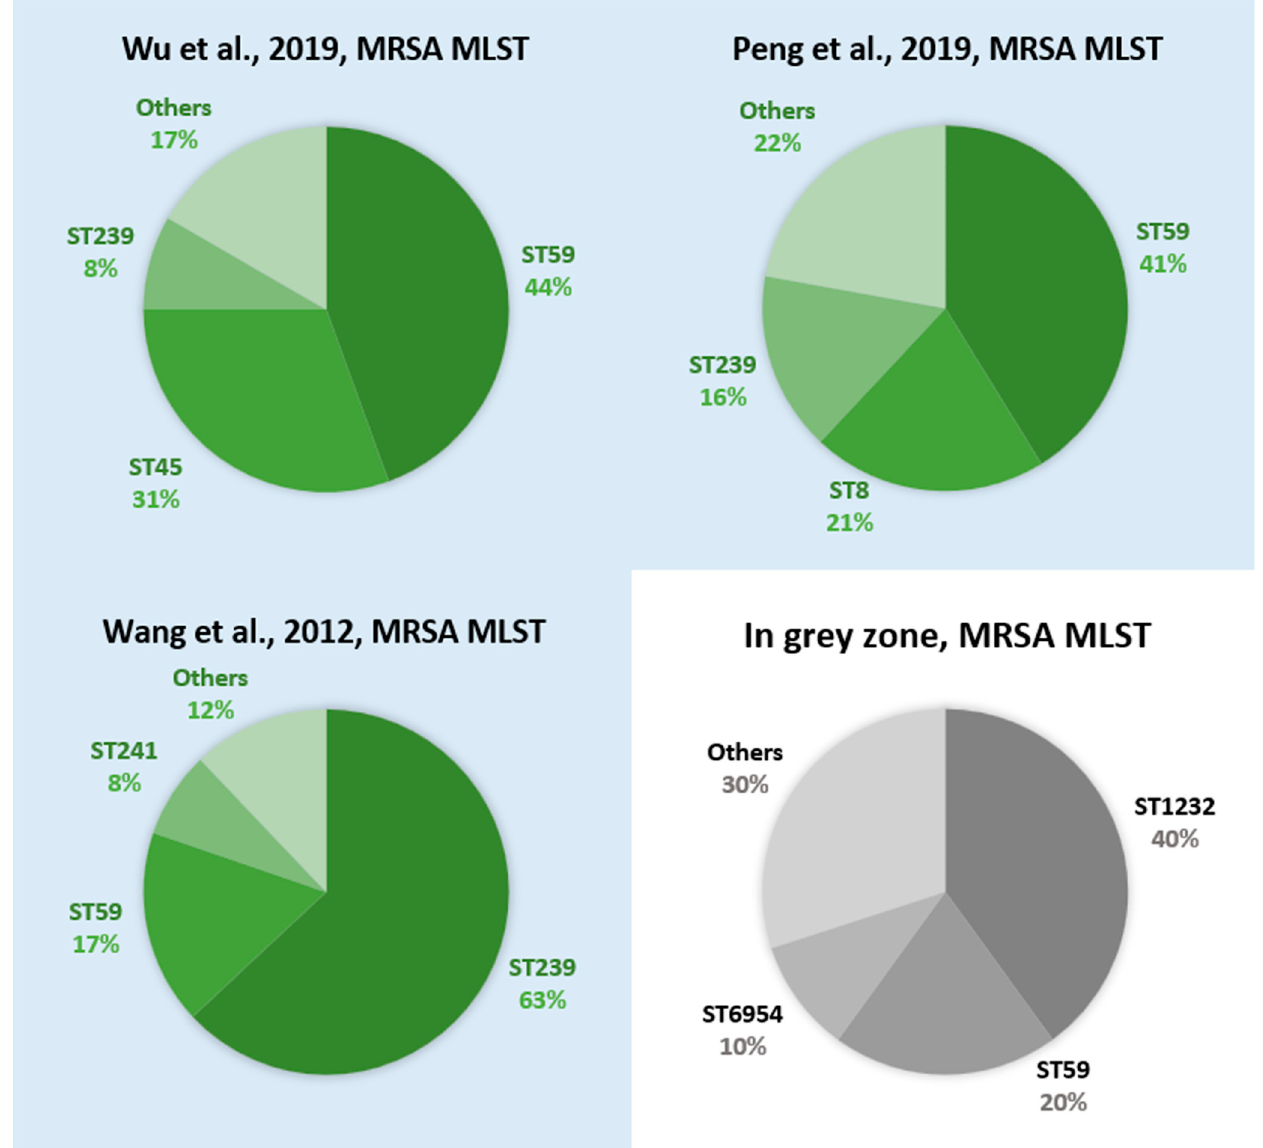
Figure 4. Multilocus sequence types of MRSA from Wu et al. [27], Peng et al. [28], Wang et al. [29], and the grey ‐ zone group in this study. The previous studies [27–29] showed that the common se ‐ quence types of MRSA infection in Taiwan were ST59 and ST239, followed by ST45 and ST5. In this study, the MRSA isolates in the grey ‐ zone group comprise uncommon sequence types such as ST1232, ST6954, and other types (accounting for 80%). Literature review of S. aureus epidemiology investigation in Taiwan is shown in Supplementary Table S3.